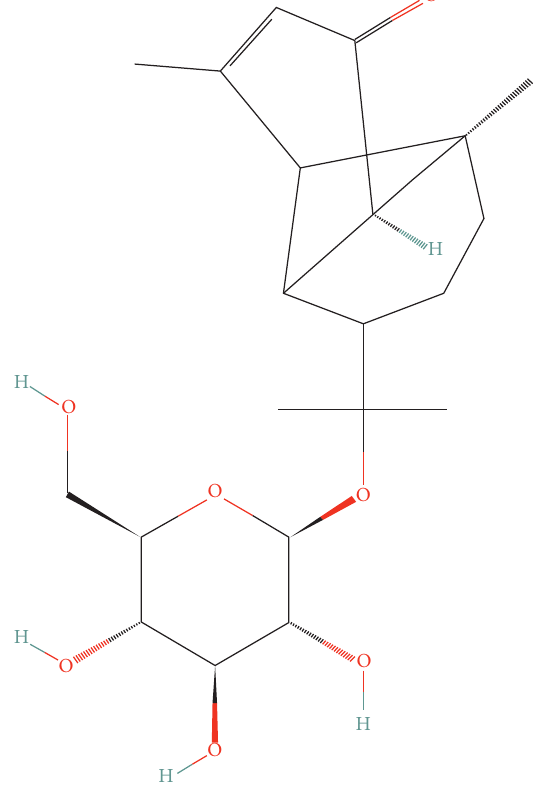
Figure 2: Tinocordiside compound 2D chemical structure